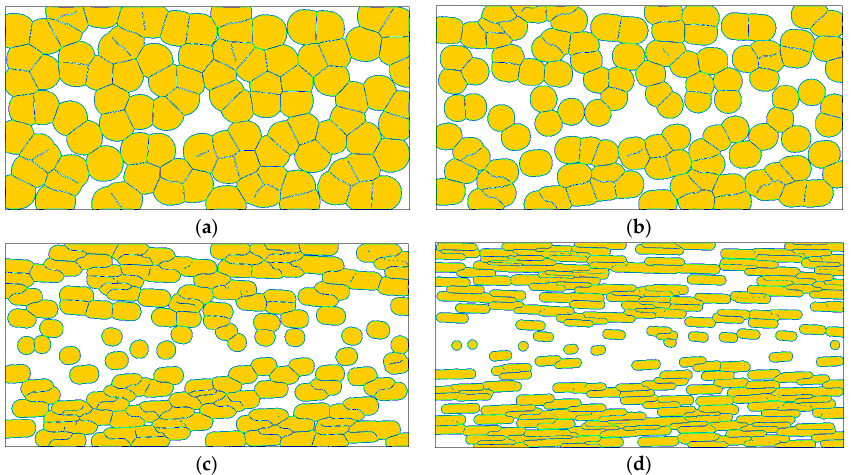
Figure 5. Simulated crystallization morphologies in the crystal order parameter field for different flow strength without considering the interface anisotropy ( i.e. , ε = 0): ( a ) ˆ γ “ 1.0, t “ 800; ( b ) ˆ γ “ 10, t “ 600; ( c ) ˆ γ “ 30, t “ 400; ( d ) ˆ γ “ 100, t “ 200. Here the time instants are chosen to ensure the results reach similar sizes of crystallized regions.